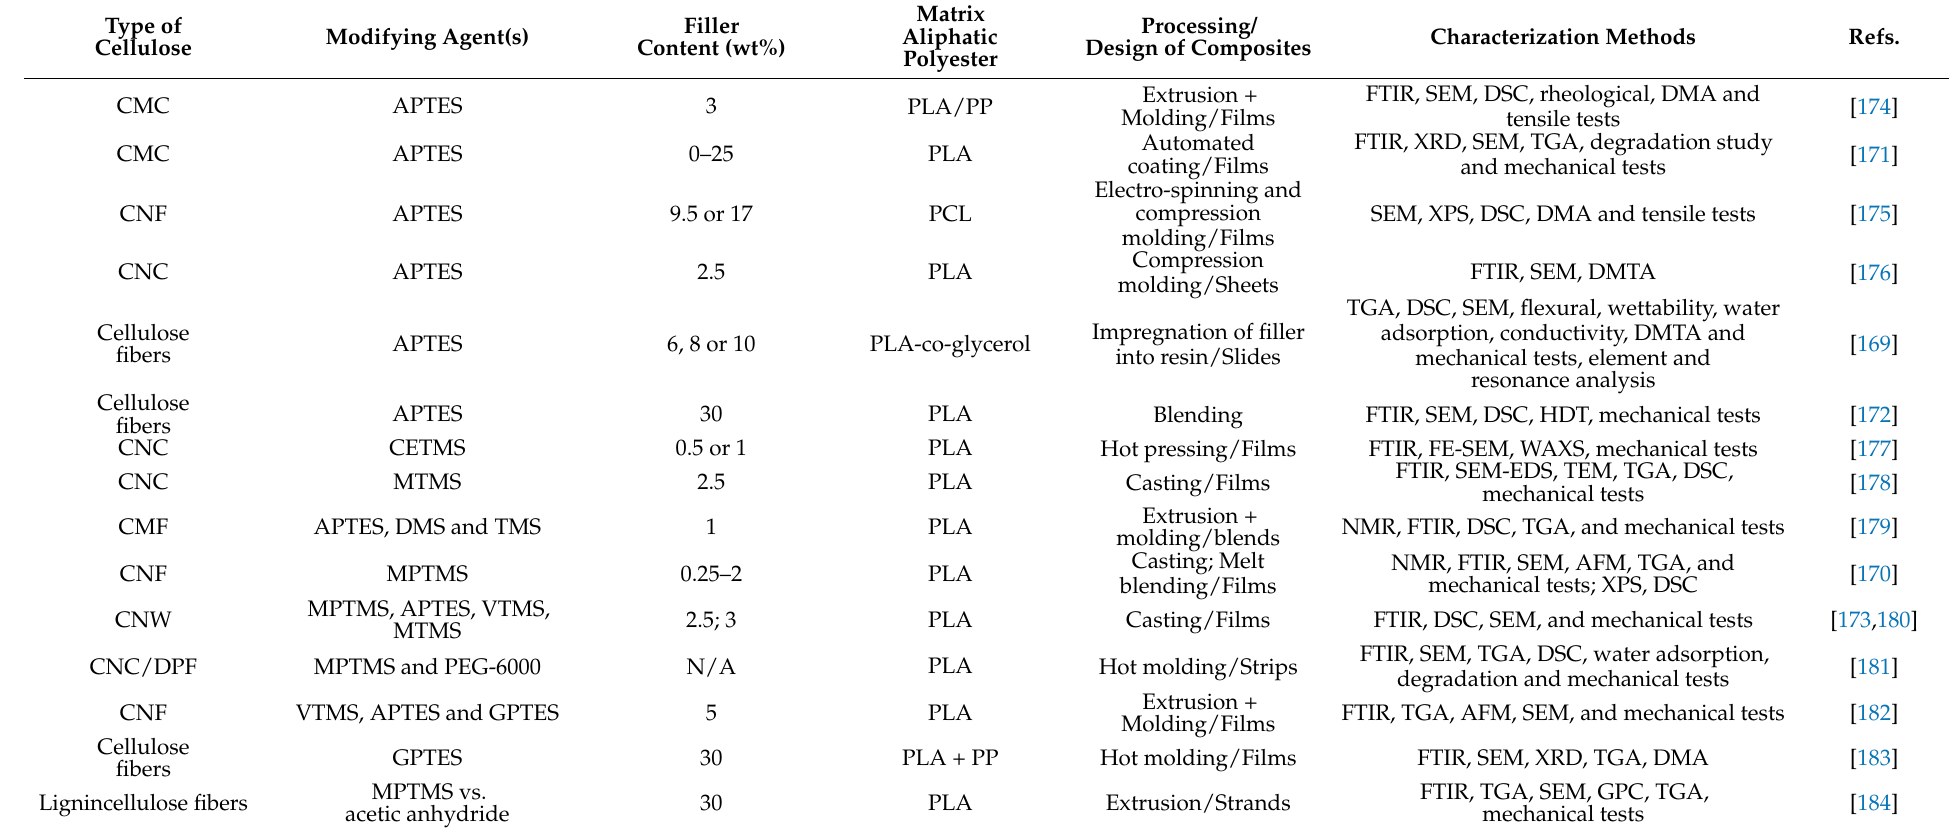
Table 6. Selected studies on covalent modification of cellulose micro- and nanomaterials via silanization for the preparation of composites with aliphatic polyesters. Type of